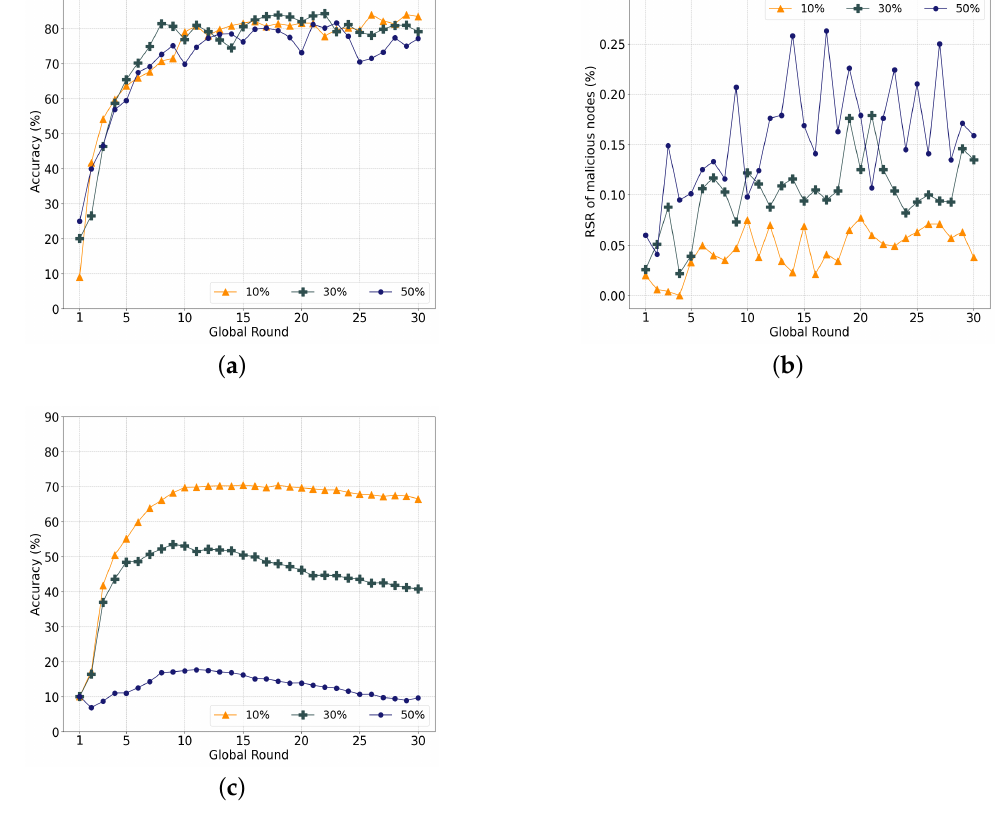
Figure 12. Evaluation of our system with label-swapping attacks. ( a ) Performance of the proposed system; ( b ) RSR with varying ratios of attackers; ( c ) Performance of legacy FedAvg